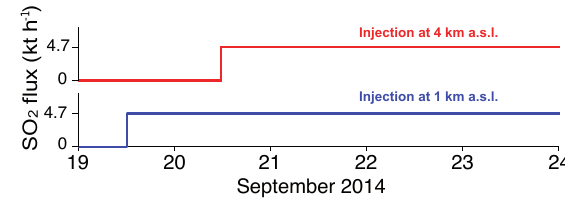
Figure 5. Simple source term (i.e. flux and altitude of injection of emissions as a function of time) initialising chemistry-transport simulations of the Bárðarbunga SO 2 cloud dispersal toward Europe in late September